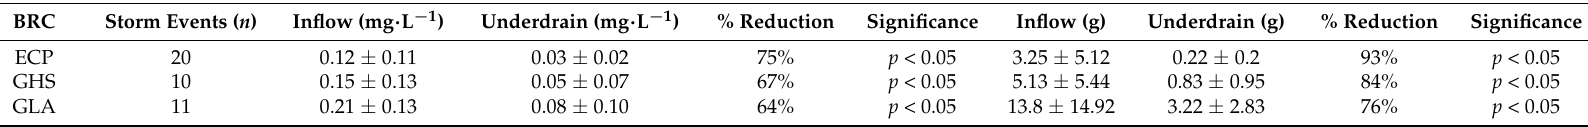
Table 4. Inlet and underdrain T-P mean concentration (mg · L − 1 ) and loading (g) for three bioretention cells (BRC) monitored at Grove, OK from 2014 to 2015. BRC